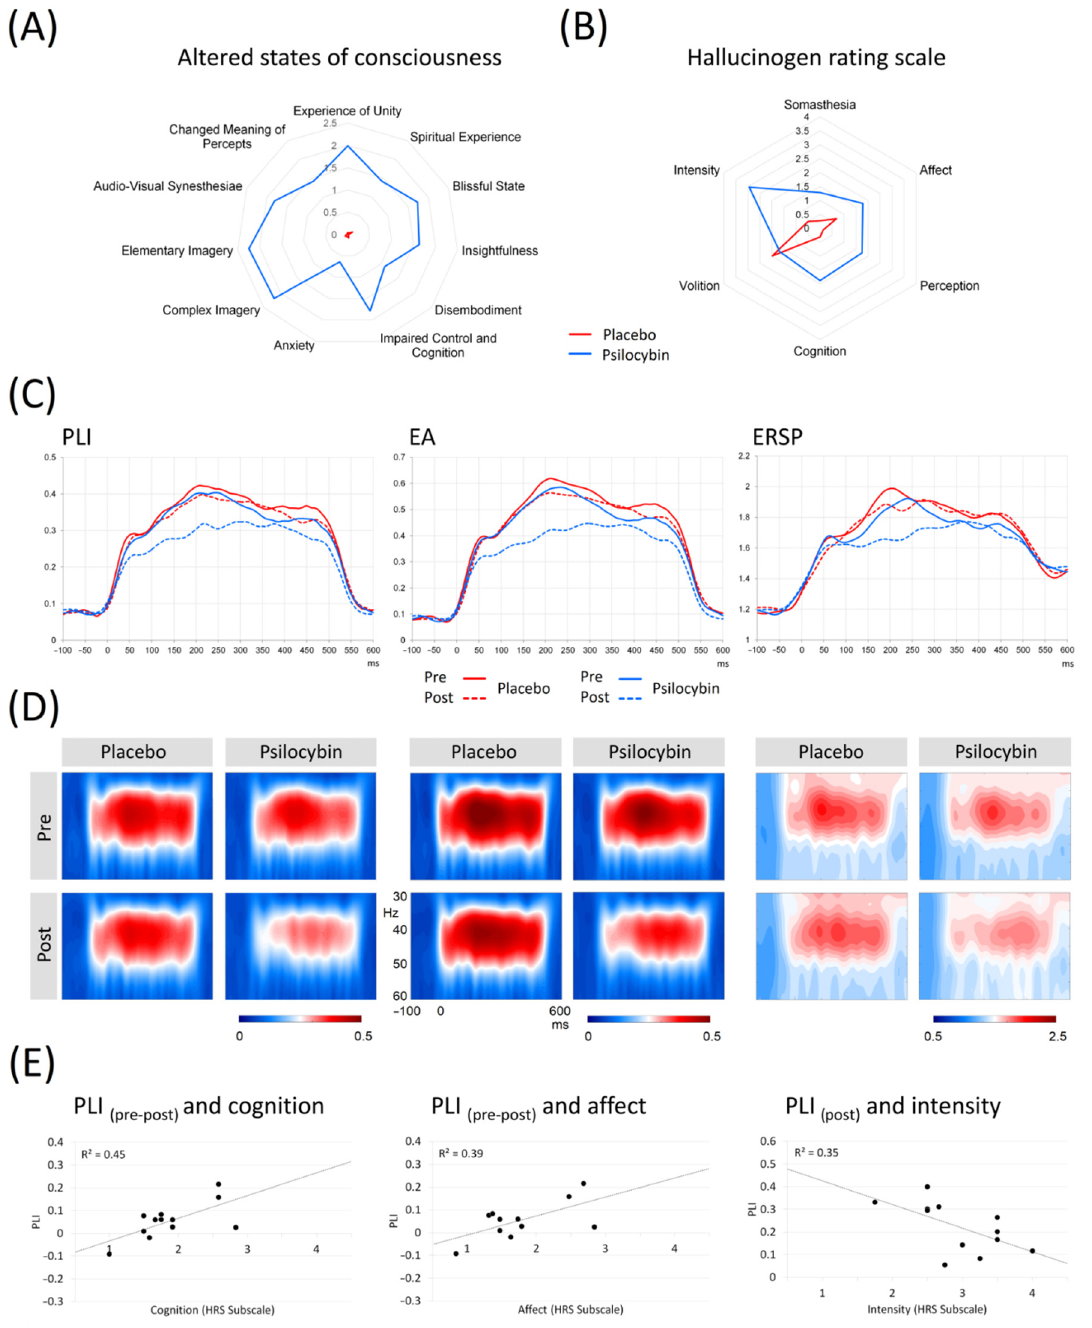
Figure 1. ( A ) The graph shows comparisons of 11 factors from the Altered states of consciousness scale, including the clustering of factors into three main subscales Oceanic boundlessness, Self-disintegration and Perception in 12 subjects during psilocybin intoxication vs. placebo. ( B ) The graph shows comparison of 6 factors from the Hallucinogen rating scale in 12 subjects during psilocybin intoxication vs. placebo. ( C ) Grand averages of the PLI, EA and ERSP curves across fronto-central ROI in pre-placebo, post-placebo, pre-psilocybin, and post-psilocybin conditions. ( D ) Time-frequency plots of PLI, EA and ERSP. ( E ) Scatterplots showing significant correlations between PLI difference values and facets of HRS—affect, cognition; scatterplot showing significant correlation between PLI values in the peak of intoxication and HRS facet intensity. Legend: PLI = Phase-locking index; ERSP = Event-related spectral perturbation; EA = Evoked amplitude; Pre = measurement before drug intake; Post = measurement in the peak of